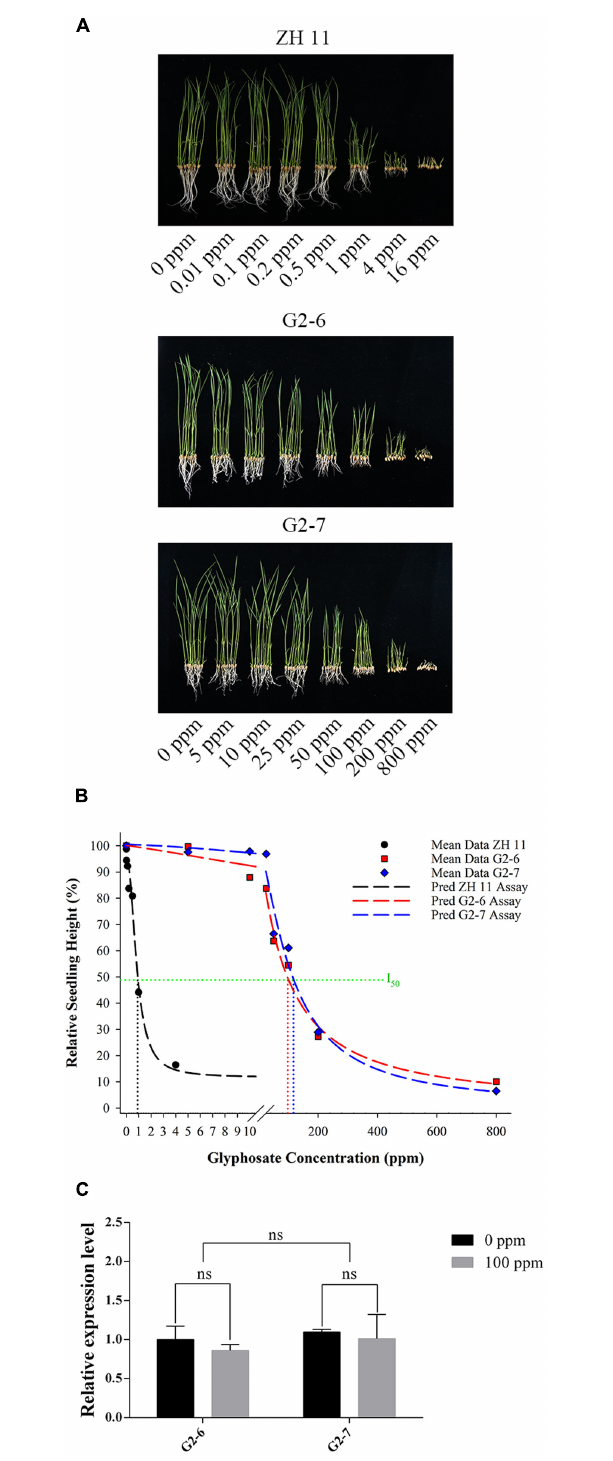
FIGURE 4 | Glyphosate-tolerance assay on hydroponic culture. (A) ZH11, G2-6, and G2-7 seedlings were grown in 1 / 2 Yoshida hydroponic culture with 1 mM NH 4 NO 3 , containing different concentrations of glyphosate, for 10 days. (B) Dose-response curves for ZH11, G2-6, and G2-7 were